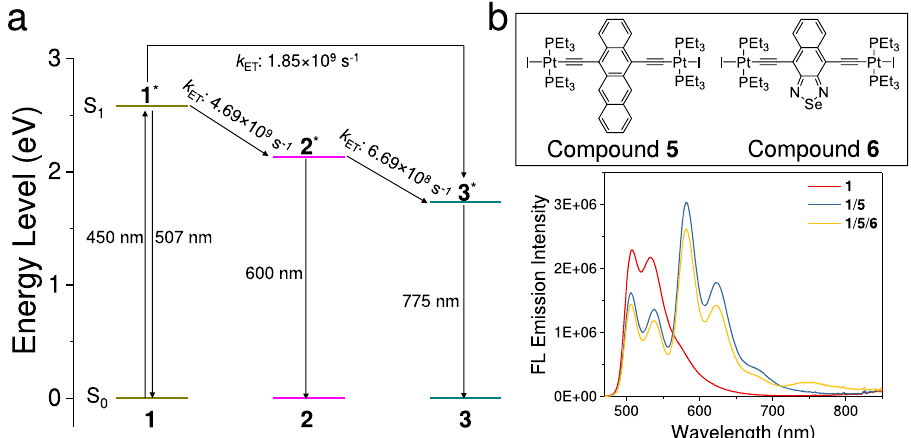
Fig. 6 Sequential energy transfer parameters and control experiment. a Energy level diagram for energy transfer in supramolecular copolymers 1 / 2 / 3 . It is assumed that S 0 → S 1 electronic transition exclusively takes place for 1 upon 450 nm excitation. b Steady-state fl uorescence emission changes upon titrating 5 and 5 / 6 into the supramolecular polymers of 1 ( c : 8.0 × 10 − 5 mol L − 1 for 1 in MCH, 1.6 × 10 − 5 mol L − 1 for 5 , and 8.0 × 10 − 6 mol L − 1 for 6 in MCH). The k ET refers to the energy transfer rate between donor and